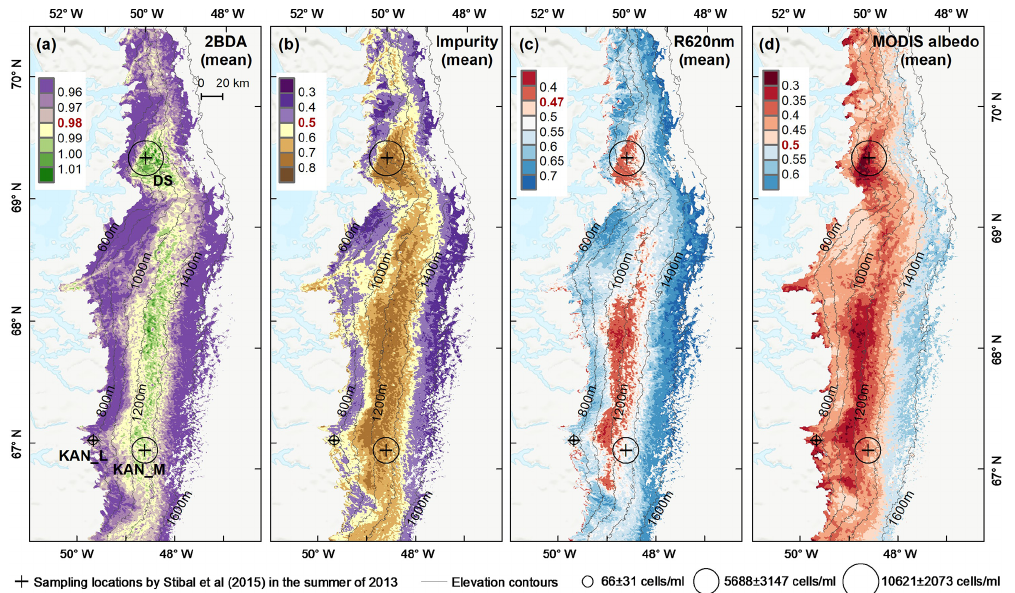
Figure 5. Spatial patterns of the mean 2BDA index (a) , impurity index (b) , reflectance at 620nm (c) , and MODIS broadband albedo (d) over the bare ice zone during July and August from 2004 to 2011. The elevation contours illustrate the spatial variations of each variable with altitude. The cross labels show the spatial locations of the field sites DS, KAN_L, and KAN_M and magnitude of glacier algal abundance (circle labels) measured by Stibal et al. (2015) in